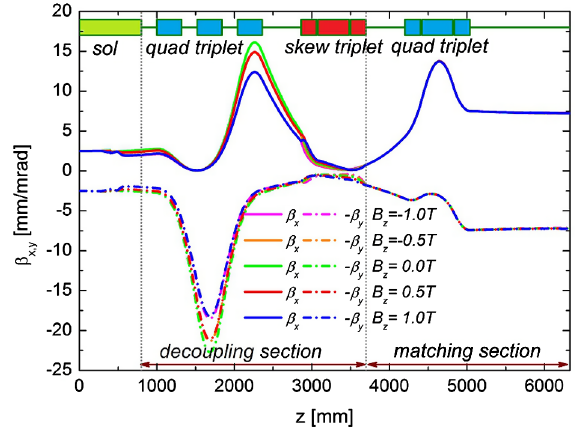
FIG. 6. Horizontal and vertical beta functions of the beam along the EMTEX beam line for different solenoid field strengths. The gradients of all quadrupoles (regular and skew) are constant. The shape of the horizontal and vertical beta function does depend on the solenoid field strength just between the solenoid entrance and the exit of the last skew quadrupole, i.e., along the part of the beam line where interplane coupling is nonzero. Behind the last skew quadrupole all coupling is re- moved and from this position on the shape of the beta function is invariant under solenoid field strength variation.